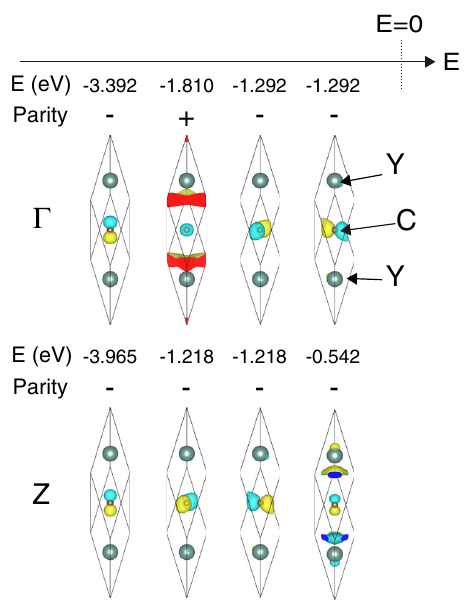
FIG. 7. Parity eigenvalues in Y 2 C. Eigenenergy, parity eigen- values, and spatial distributions of eigenstates of occupied bands at the Γ and Z points of Y 2 C in the GGA. The center of the unit cell is located at the C atom. The energy is measured from the Fermi